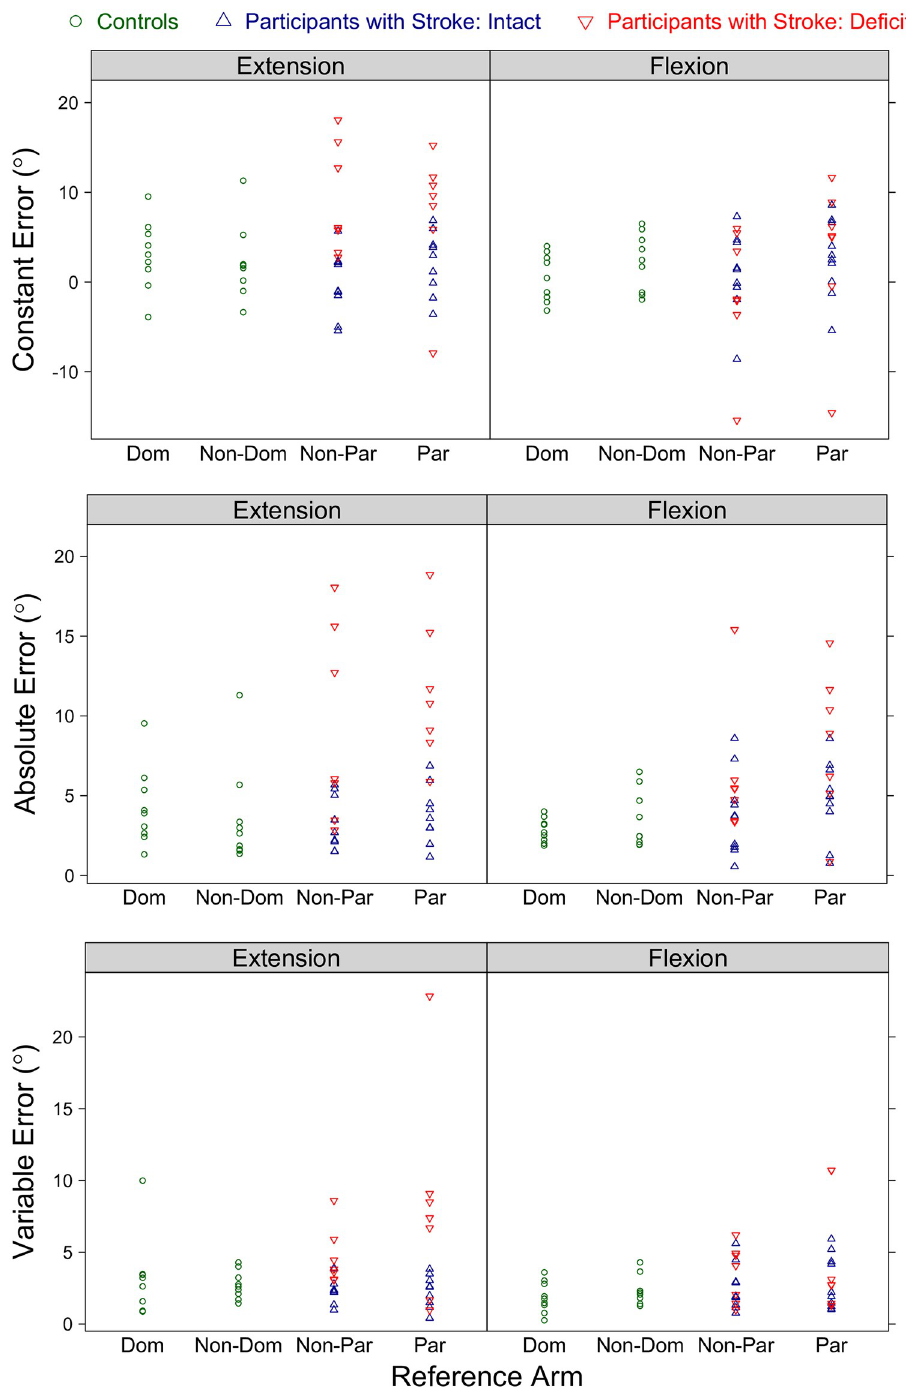
Fig 5. Between-arms position-mirroring results for each participant across all tested conditions. Shown are the robotic assessment results on the between-arms position-mirroring task for the controls and participants with stroke. Each participant’s (Top) constant error, (Middle) absolute error, and (Bottom) variable error are given as a function of the reference arm and reference target location. The controls’ data are reproduced from [48] to permit comparison of the between-arms position-mirroring ability of our participants with stroke to that of individuals without neurological impairments. (Dom: dominant, Non-Dom: non-dominant, Non-Par: non-paretic, Par: paretic).